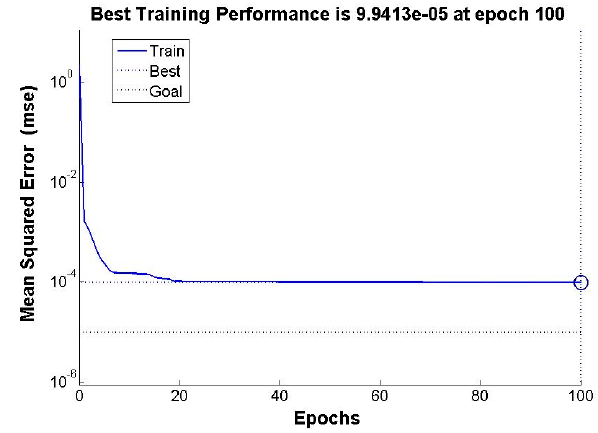
Figure 8. Mean square error curve.